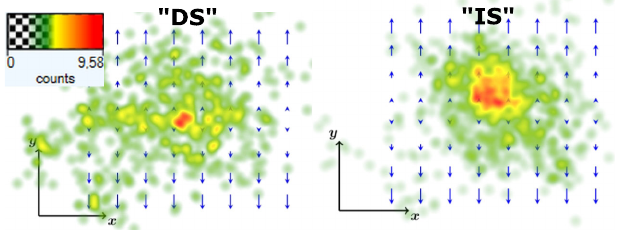
FIG. 5. Heat maps of the first vector field (V1) when students applied the differential strategy (left) or the integral strategy (right). Data were taken from all